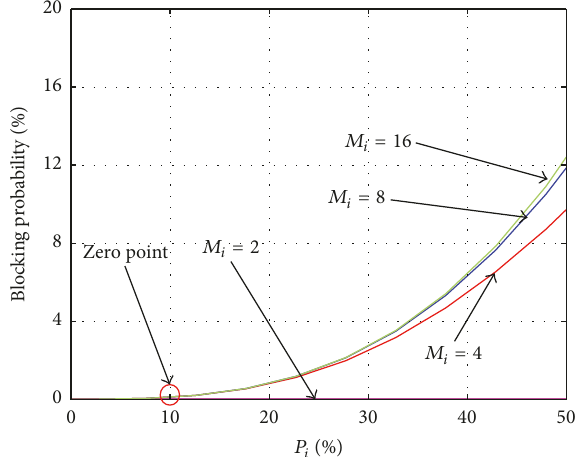
Figure 6: Downlink blocking probability comparison in different 𝑀 𝑖 s.